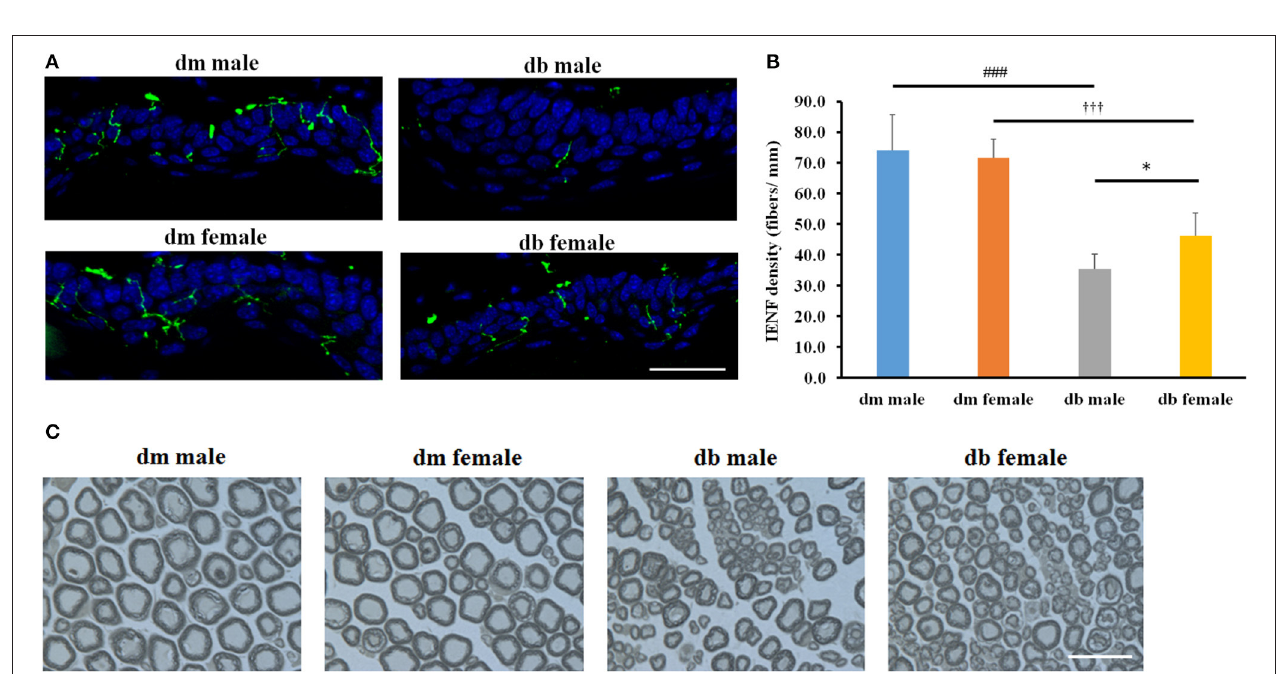
FIGURE 4 | The differences of regional blood flow between males and females. Laser Doppler images show that male diabetic mice displayed a significant reduction of regional blood flow in footpad (A) and sciatic nerve (B) tissues compared to female diabetic mice. (A,B) show representative images of regional blood flow in foot pad and sciatic nerve tissues. (C) shows the quantitative data of regional blood flow. PU, Perfusion units; ROI, Region of interest. # P < 0.05, ## P < 0.01 db/m male group vs. db/db male group, db/m female group vs. db/db female group; * P < 0.05, db/db male group vs. db/db female group. N = 10/group. Lowest blood flow is indicated in blue, maximum blood flow in red, and intermediate grading in green and yellow.